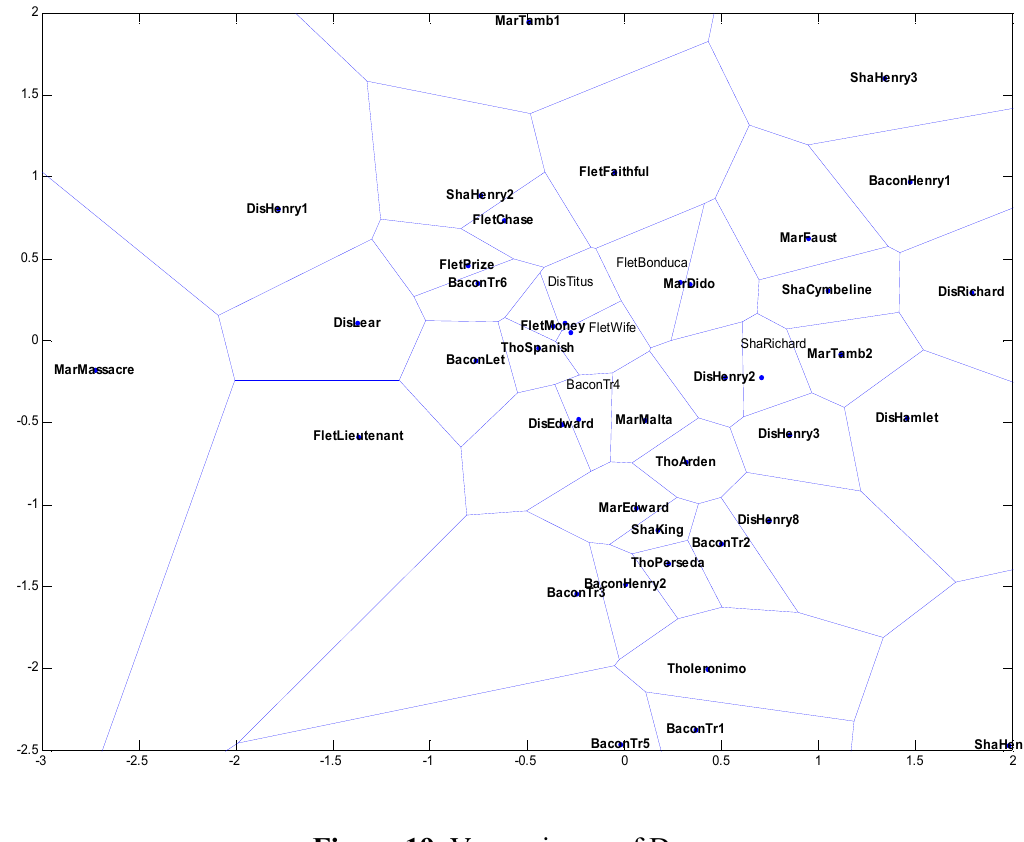
Figure 19. Voronoi map of D bigram